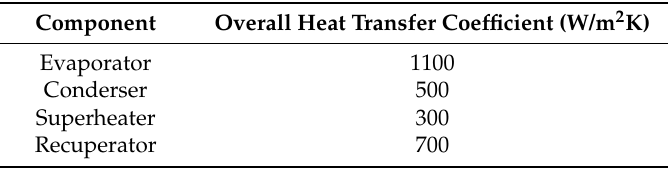
Table 3. Overall heat transfer coefficients for heat exchangers